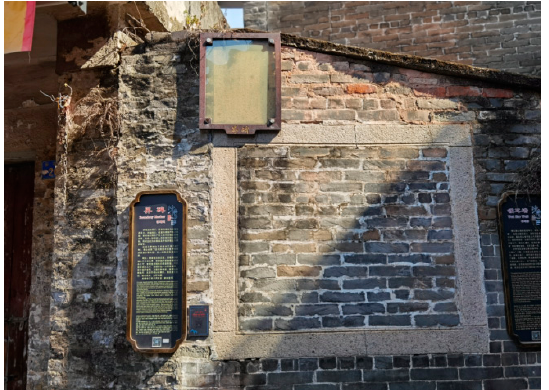
Figure 19. Boundary monument wall. (Source: the authors).